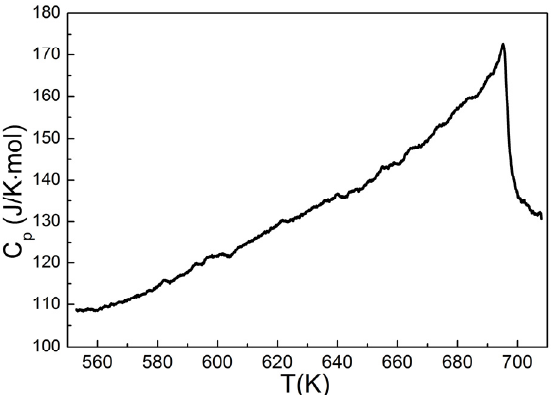
Figure 4. Temperature dependence of heat capacity for CuCrS 2 .